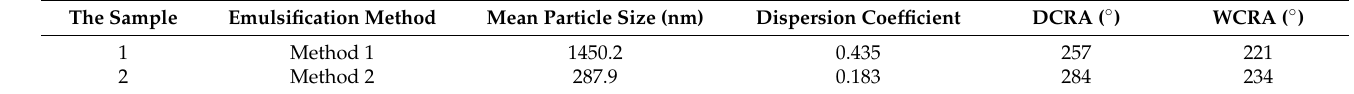
Table 1. Effect of particle size of finishing agent emulsion on crease recovery angle of finishing silk fabric. The Sample Emulsification